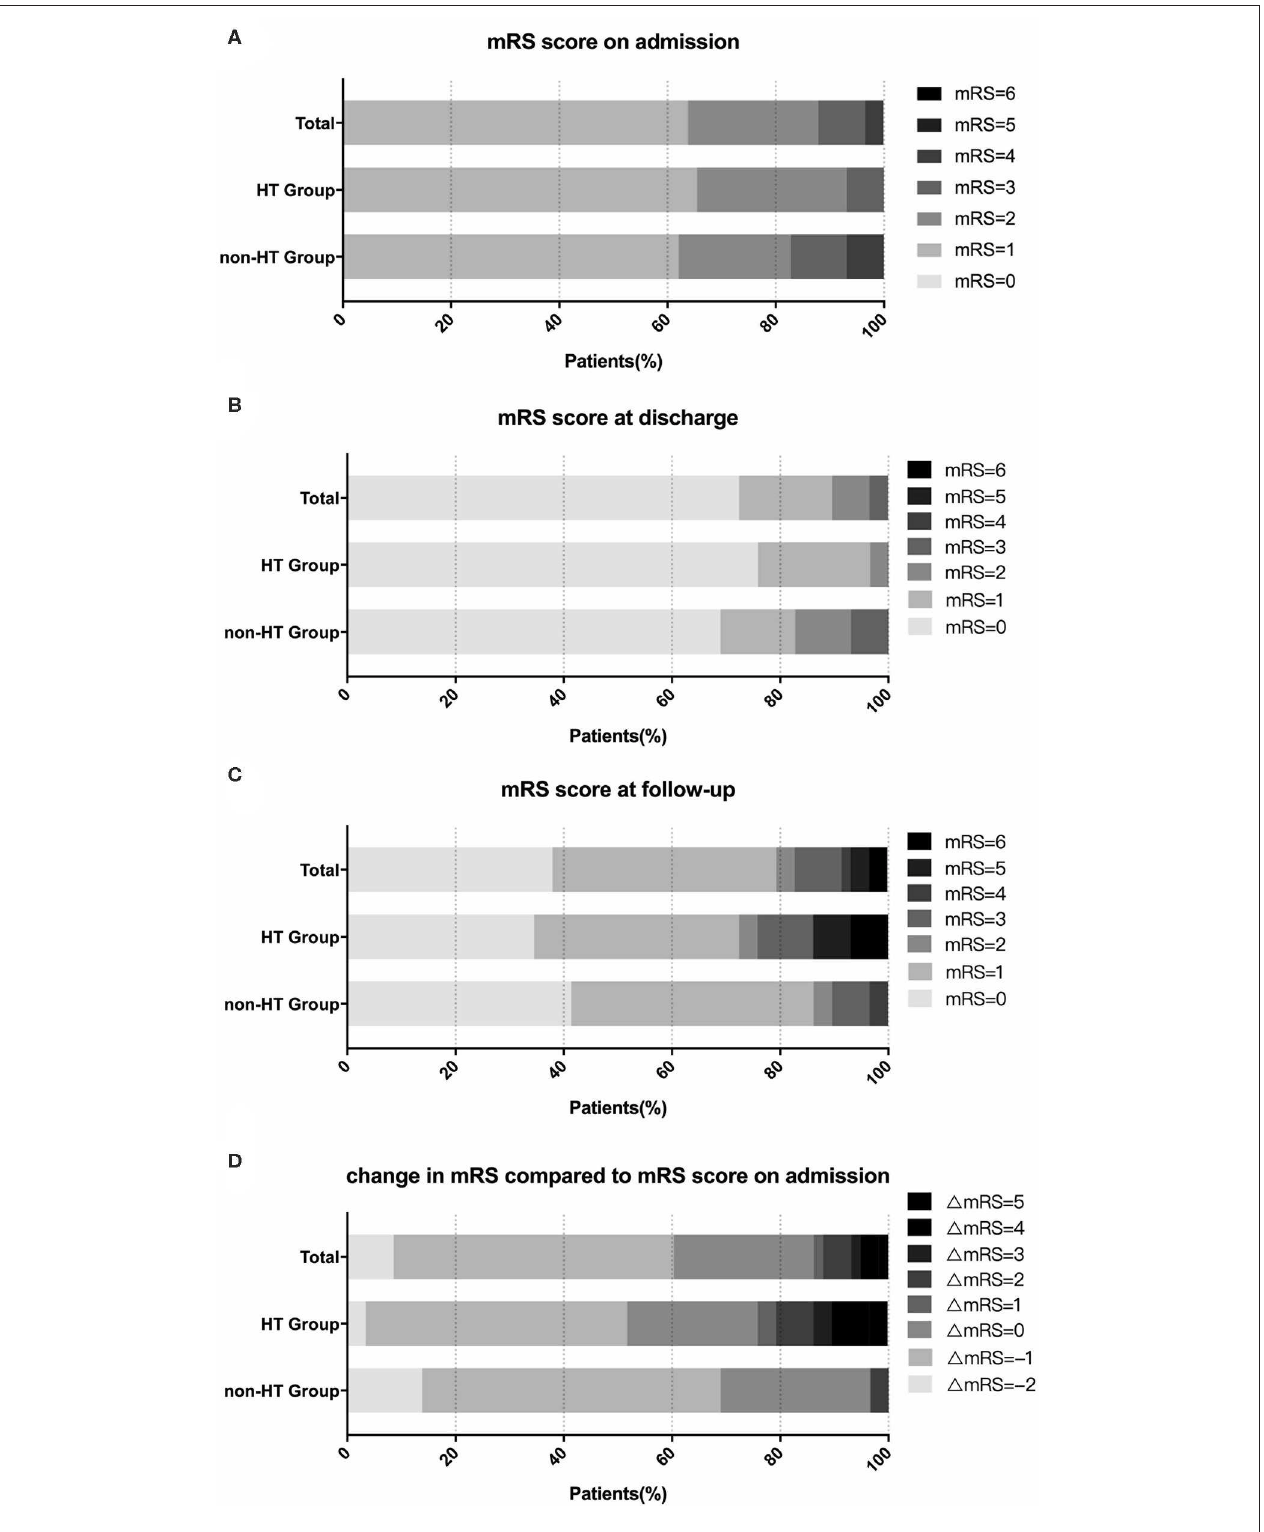
FIGURE 3 | Change in modified Rankin Scale (mRS) scores in the propensity score-matched cohort. The graphs show the proportions of patients stratified by mRS score. There was no statistically significant difference in mRS scores on admission (A) , at discharge (B) , and at follow-up (C) between the hemorrhagic transformation (HT) and non-HT groups. Compared to their neurological status on admission, the mRS score at follow-up showed a deterioration in 20.7% of patients in the HT group but 0% of the non-HT group (D) .